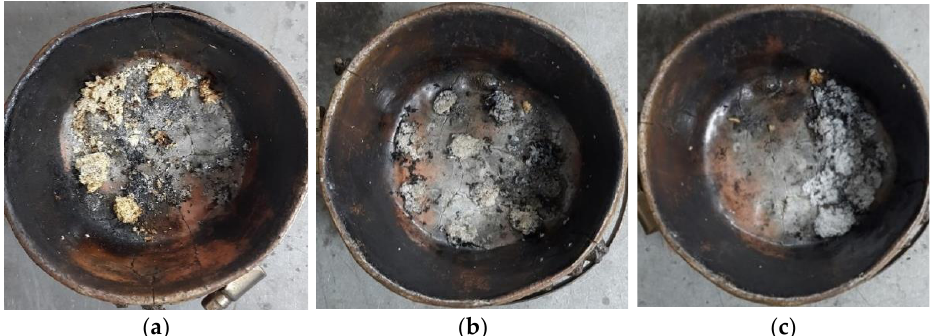
Figure 10. Solid residue after microwave pyrolysis of biomass with different options for the initial distribution of a sample in the crucible: as a set of large fragments ( a ); as a set of small fragments ( b ); on a half of the crucible bottom ( c ).